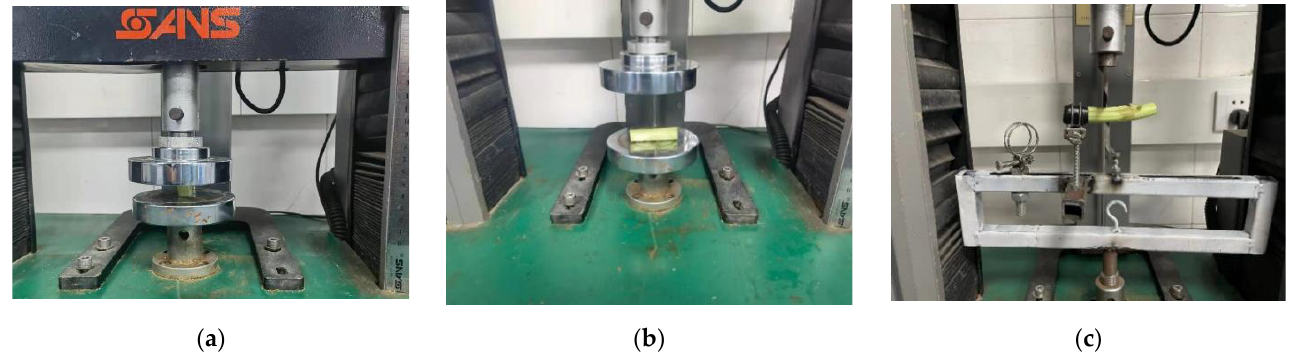
Figure 3. Mechanical properties of rape shoot stalks: ( a ) the axial compression mechanical properties; ( b ) the radial compression mechanical properties; ( c ) the shear mechanical properties. The mechanical properties curve of the rape shoot stalks are shown in Figure 4.